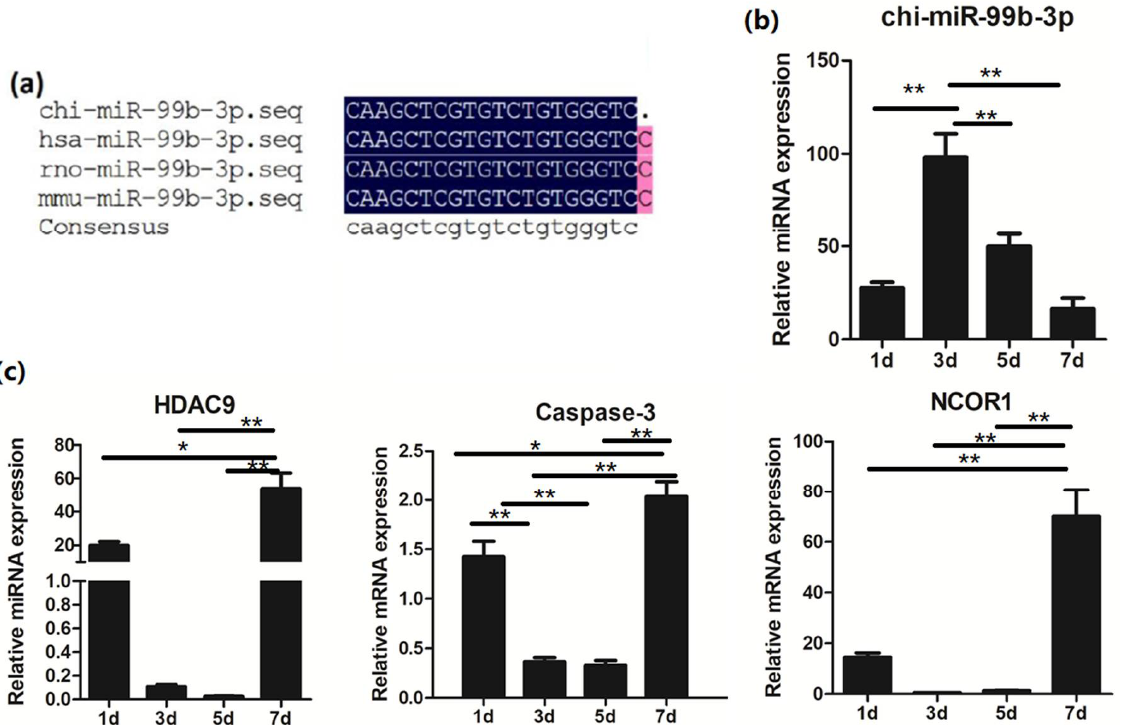
Figure 1. Relative expression of chi-miR-99b-3p and potential targets during the differentiation of SMSCs. ( a ) chi-miR-99b-3p was conserved across species. ( b ) Relative expression of chi-miR-99b-3p during the differentiation of SMSCs. ( c ) mRNA expressions of selected targets during the differentiation of SMSCs. All results are presented as means ± SEM. n = 3. * p < 0.05; ** p < 0.01.